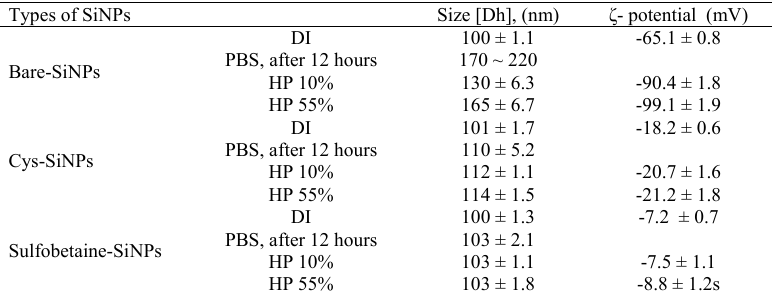
Table 1. Characterization of three types of SiNPs in different media.